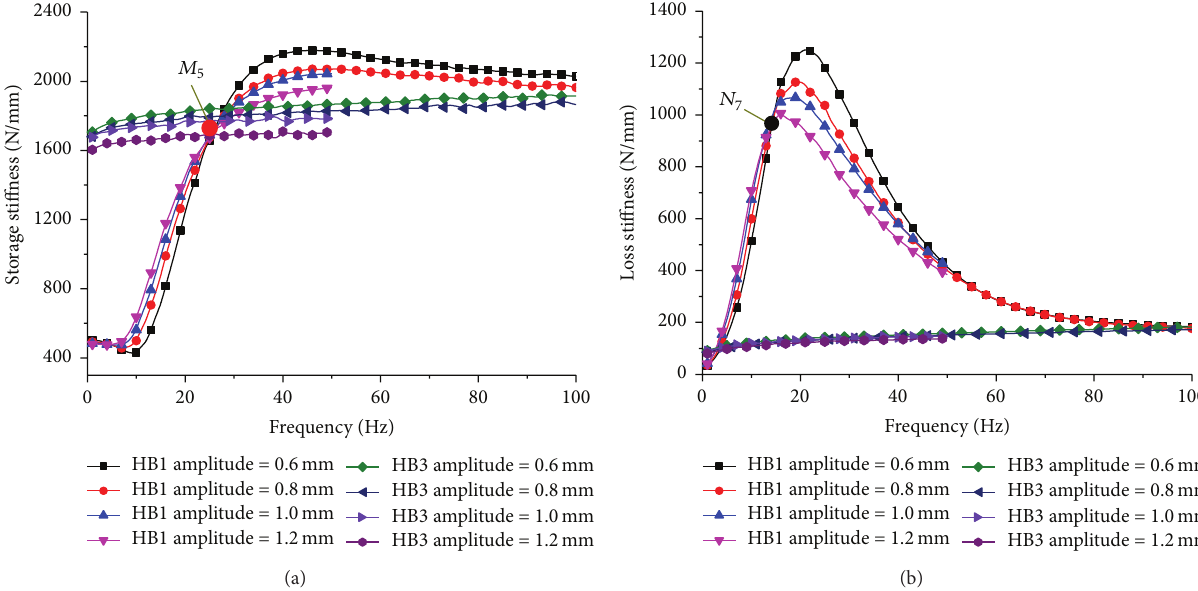
Figure 6: The test results of storage and loss dynamic stiffness of the hydraulic bushing. (a) Storage stiffness. (b) Loss stiffness.